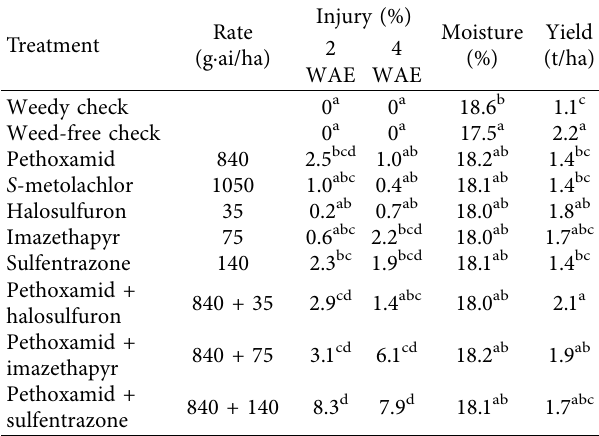
Table 1: Percent visible injury 2 and 4 weeks after crop emergence (WAE), moisture and yield of white bean treated with various PRE herbicides in 2015, 2016, and 2017.